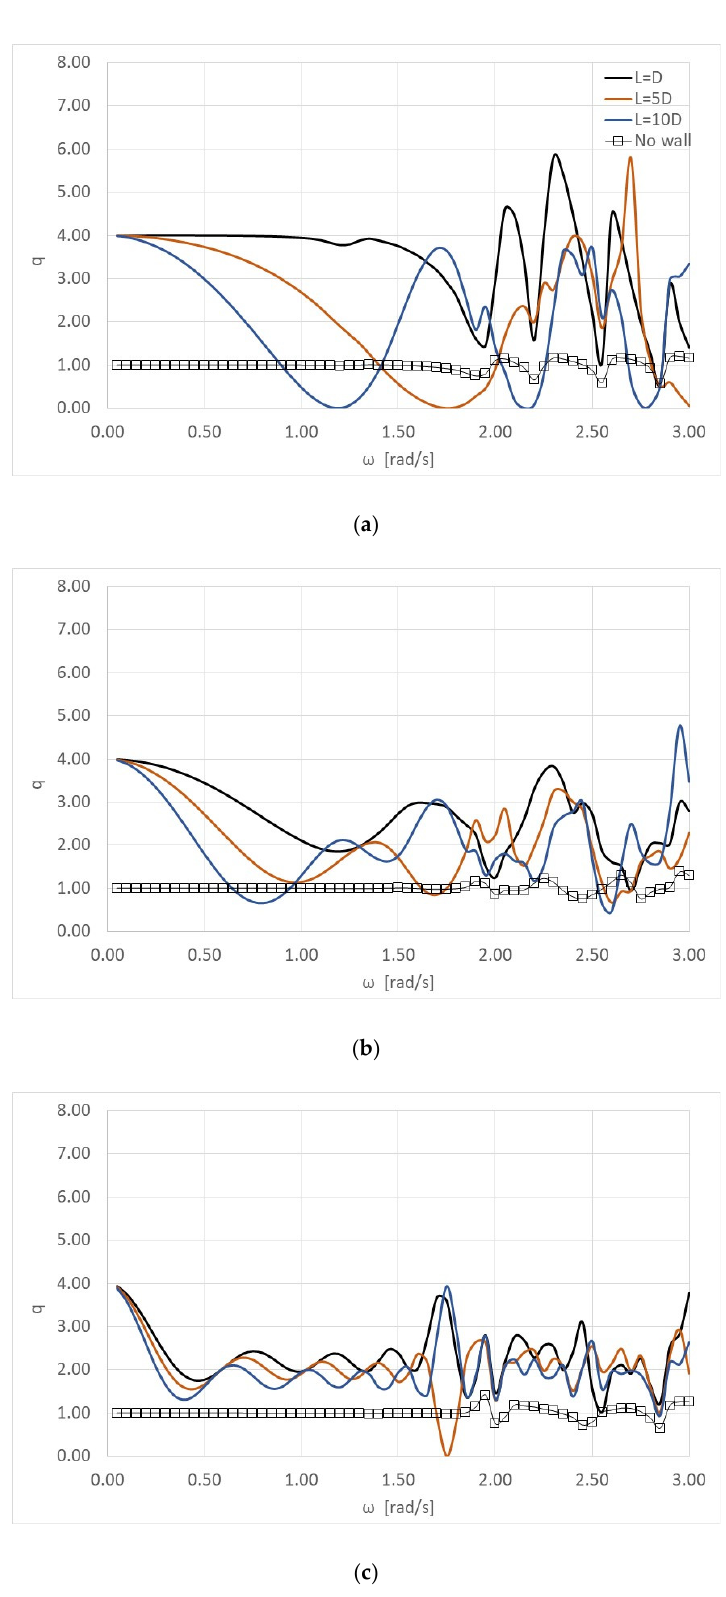
Figure 11. The q factor term of the WEC array, against ω , for the three different WEC–wall distance cases and for 60 ◦ wave heading angle. Comparison concerning the q factor of the same array without the presence of the breakwater: ( a ) parallel arrangement; ( b ) rectangular arrangement; ( c ) perpendicular arrangement.